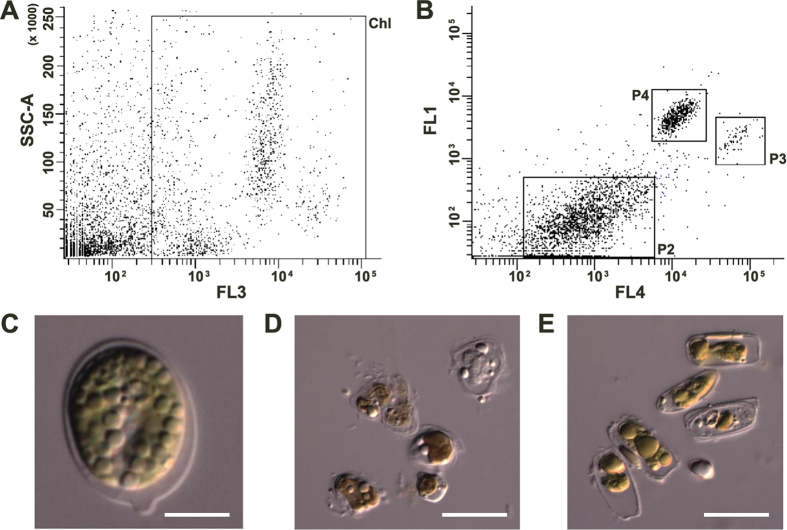
Cell sorting procedure used to isolate CTP4 strain by means of fluorescence activated cell sorting (A,B), and different clusters sorted directly onto microscope slides observed with differential interference contrast (C–E). The first sorting trait (Chl gate) was applied through the combination of inner cell complexity, SSC-A, with chlorophyll autofluorescence, FL3 (A). The final gates used to isolate the CTP4 strain combined BODIPY fluorescence (FL1) with the signal of the allophycocyanin autofluorescence channel (FL4). Strains isolated from clusters P4 (C), P2 (D) and P3 (E). The first strain was named as CTP4 (C), whereas the second corresponded to an unidentified strain with apparent cell disruption (D) and the third strain was an unidentified diatom (E). Scale bar = 5 μm.